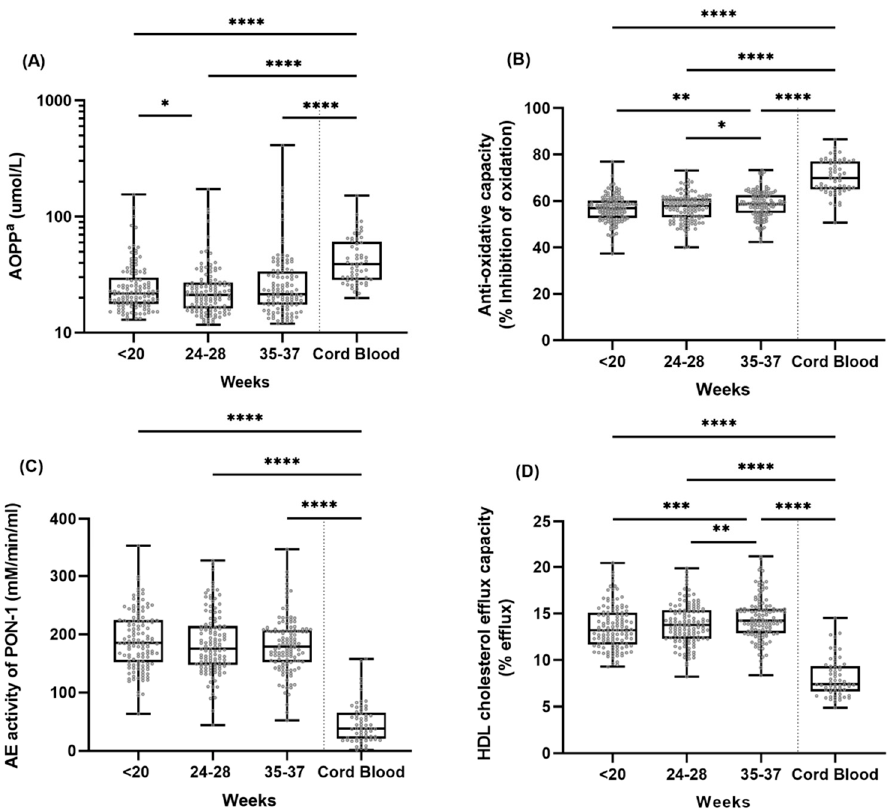
Figure 1. Advanced oxidation protein products (AOPPs) ( A ), % inhibition of oxidation ( B ), AE ac- tivity ( C ), and cholesterol e ffl ux ( D ), at three time points during pregnancy in maternal blood, and at term in cord blood. a Axis values logarithmically scaled. * p < 0.05, ** p < 0.01, *** p < 0.001, **** p <